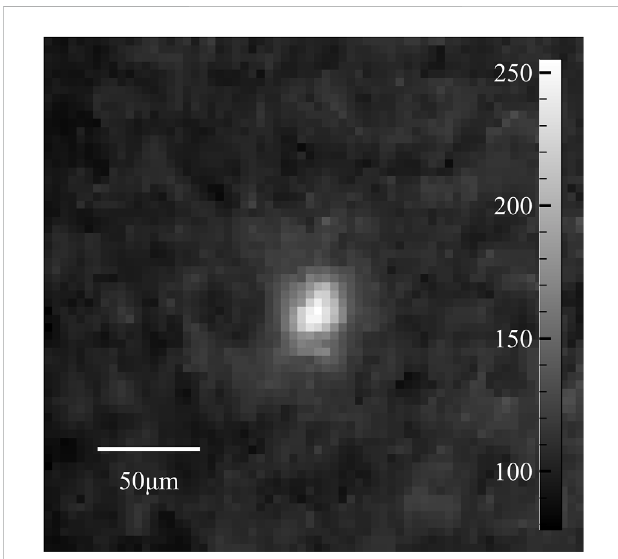
FIGURE 7 X-ray focal spot grayscale image in SGII-UP-Petawatt – picosecond system.